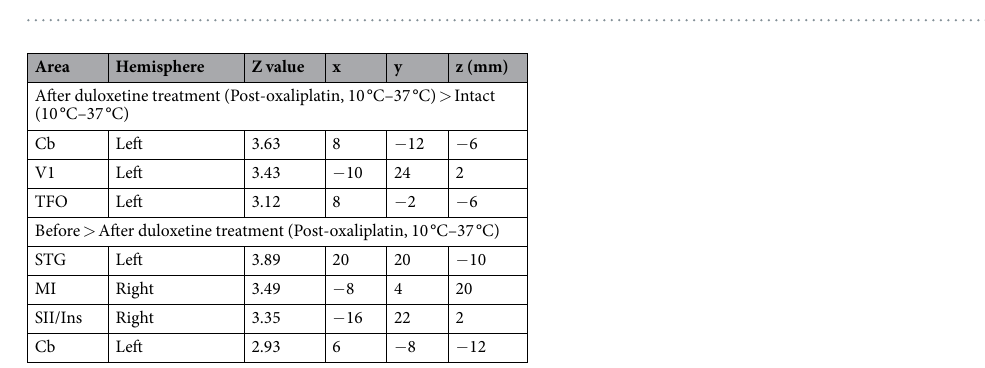
Figure 4. Effect of duloxetine on brain activity in oxaliplatin-treated macaques. ( a ) Systemic duloxetine ameliorated oxaliplatin-induced cold hypersensitivity; withdrawal latencies to 10 °C in either cycle were significantly increased ( *** P < 0.001, Paired t-test). Values are expressed as mean ± SD. ( b ) After duloxetine treatment, voxels in the secondary somatosensory cortex (SII) and the insular cortex (Ins) were no different compared to that of intact (pre-oxaliplatin infusion) macaques, (P < 0.01, uncorrected). ( c ) Activation in the SII and Ins was significantly decreased after duloxetine treatment, compared with brain activity before duloxetine treatment (P < 0.01, uncorrected; Table 4). In ( b ) and ( c ), a series of coronal slices, spaced by 4 mm, are arranged from rostral (upper-left, y = 24) to caudal (lower-right, y = − 16). Cb, cerebellum; MI, primary motor cortex.